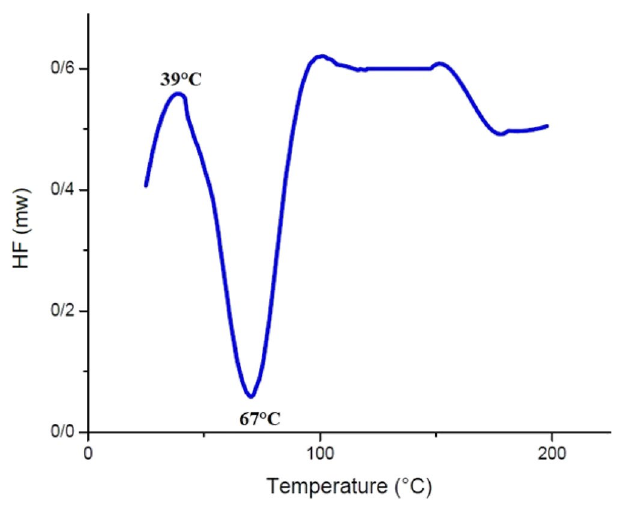
Figure 16. DSC diagram of cPNIPAAM synthesized by emulsion